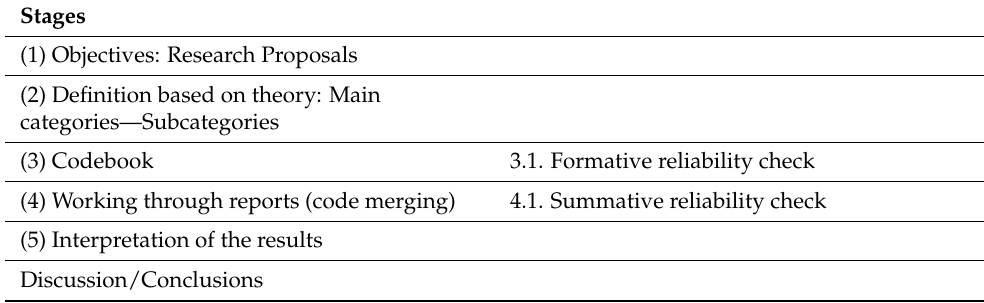
Table 1. Deductive model